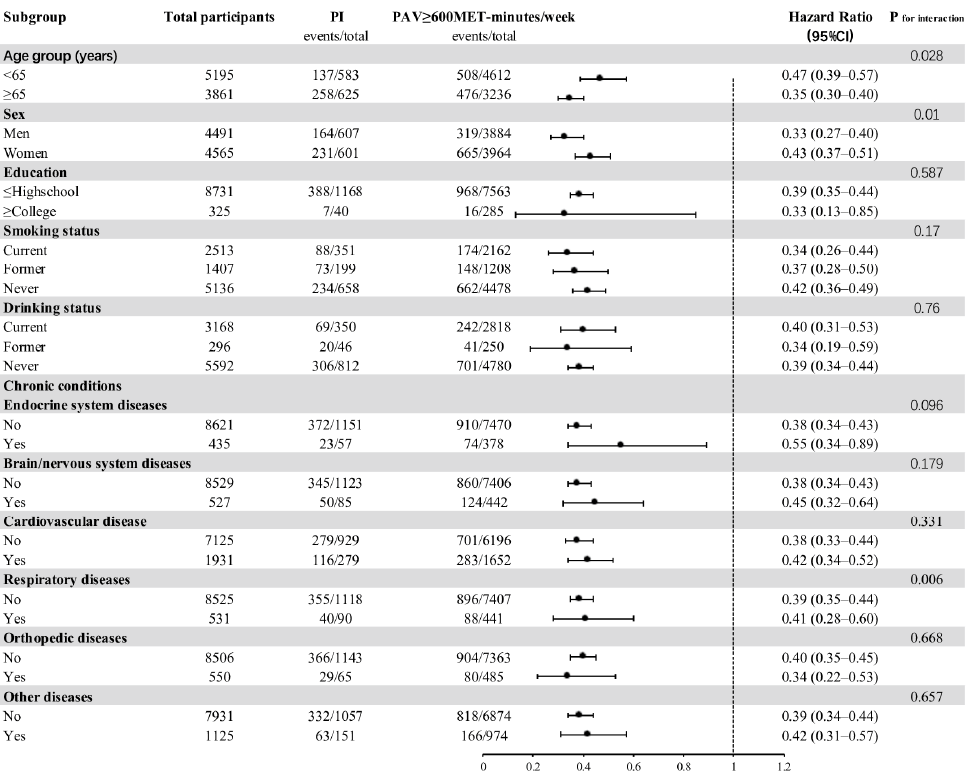
Figure 3. Subgroup analysis of the association between study participants with a PAV ≥ 600 MET- minutes/week and impaired physical function.